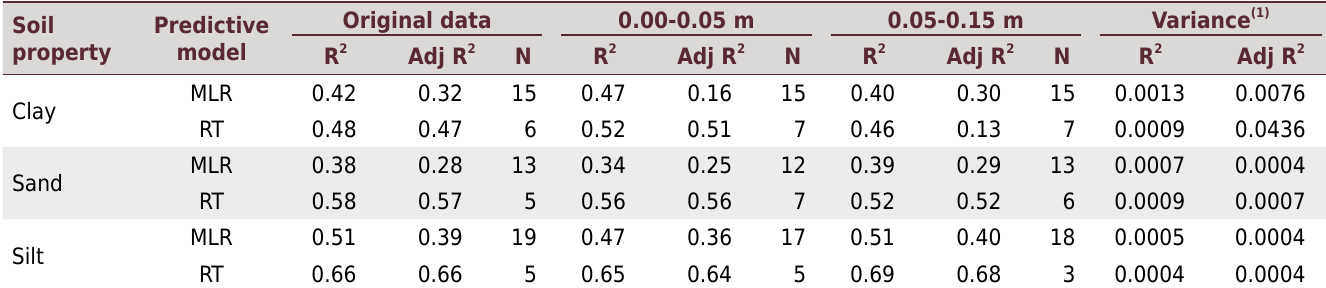
Table 3. Summary of results for all models tested in the watershed according to soil particle size, model type, and depth Soil